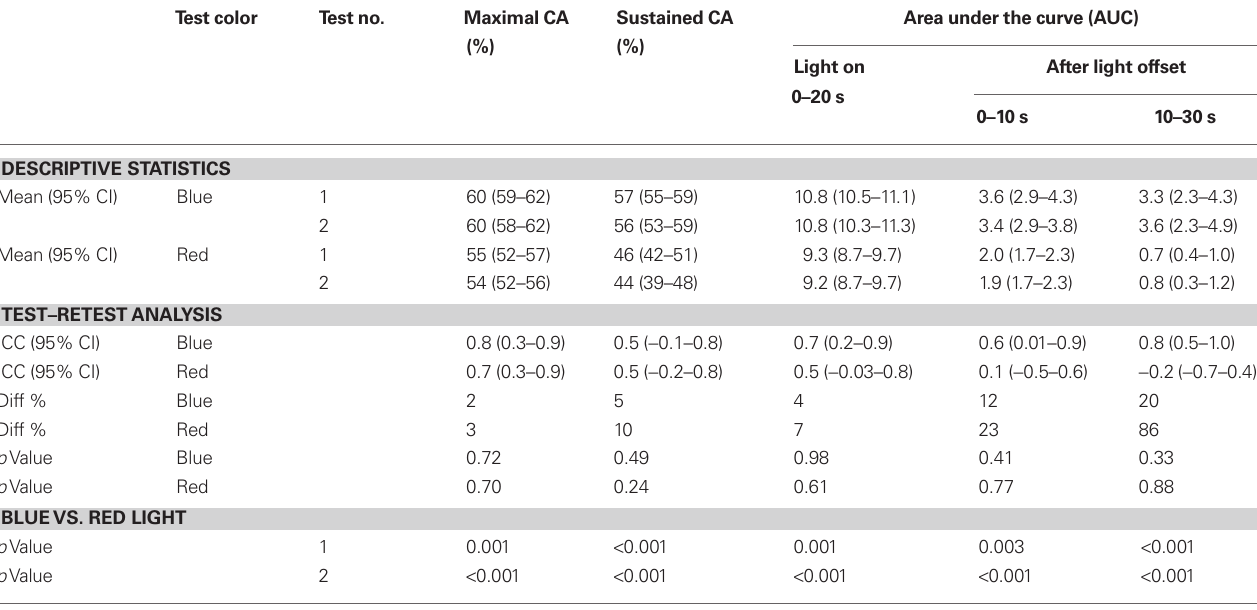
Table 1 | Summary of pupil response parameters to blue and red light stimulation obtained in two separate test sessions and the intra-class correlation coefficients